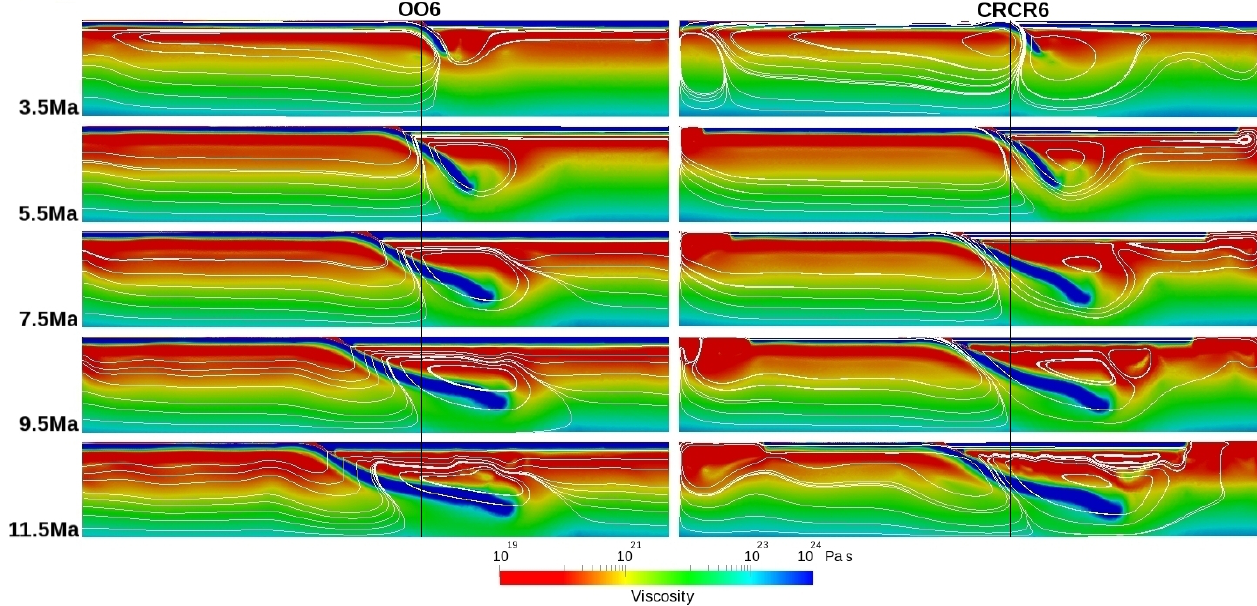
Fig. 5. Snapshots of the effective viscosity and flow pattern for 2 subduction models, on the right-model domain with ratio 6:1, closed boundaries (CRCR6), on the left-model domain with ratio 6:1, open boundaries